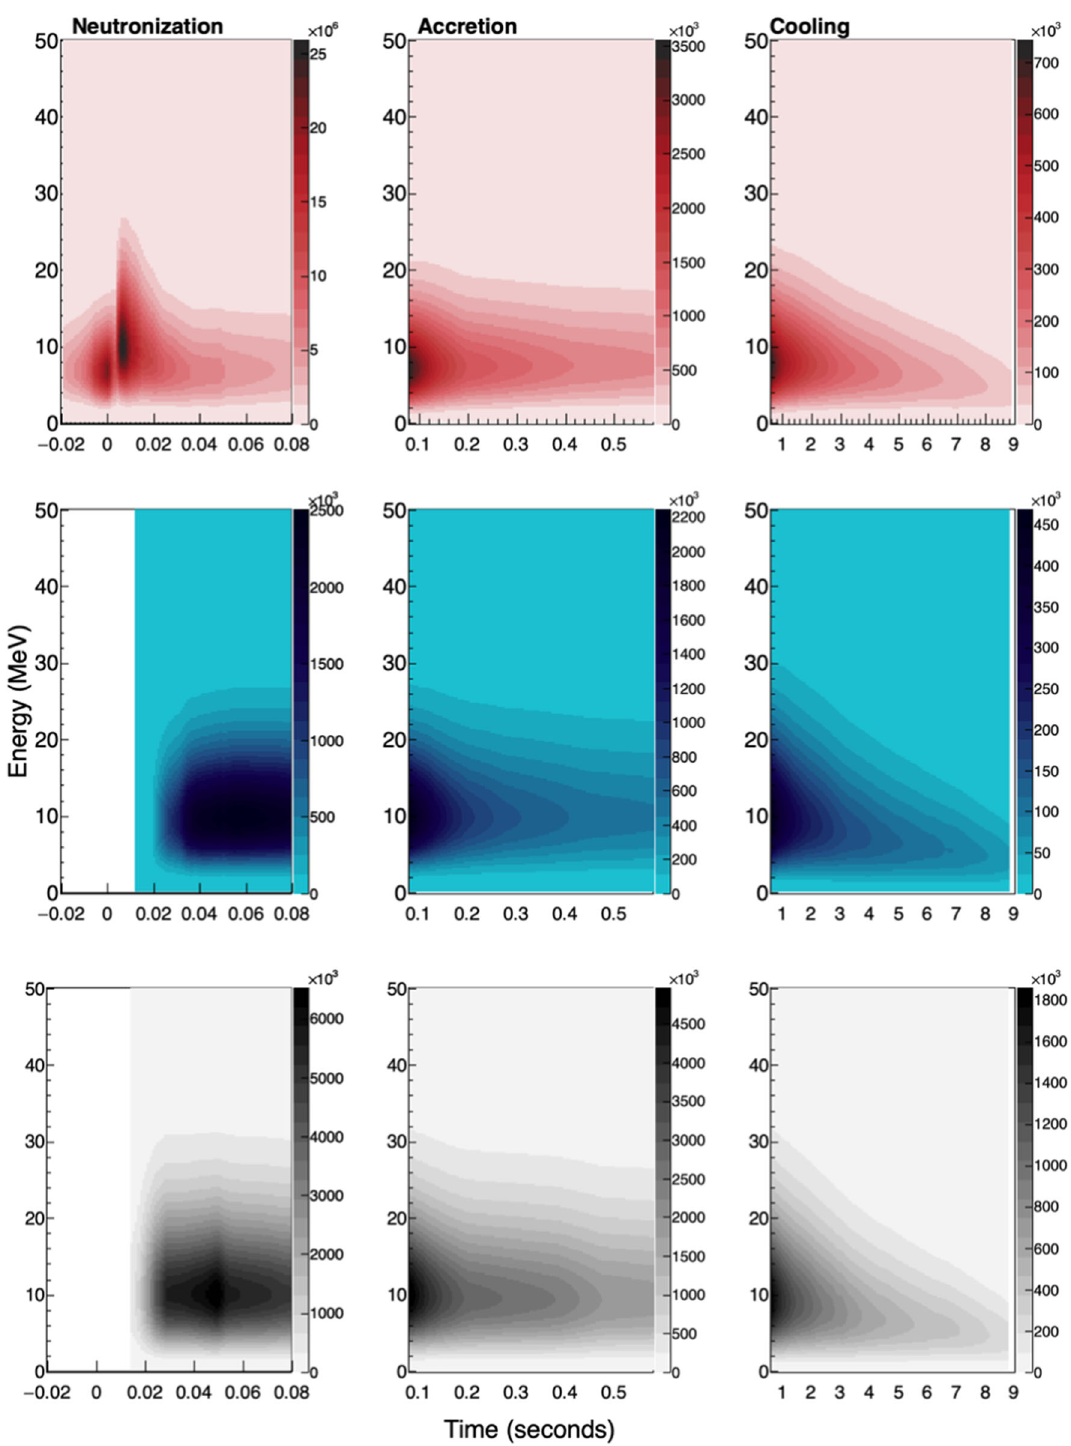
Fig. 2 Examples of time-dependent neutrino spectra for the electron- capture supernova model [8] parameterized in Fig. 1, on three different timescales. The x-axis for all plots indicates time in seconds and the y-axis indicates neutrino energy in MeV. The z-axis color-shading units are neutrinos per cm 2 per millisecond per 0.2 MeV. Note the different